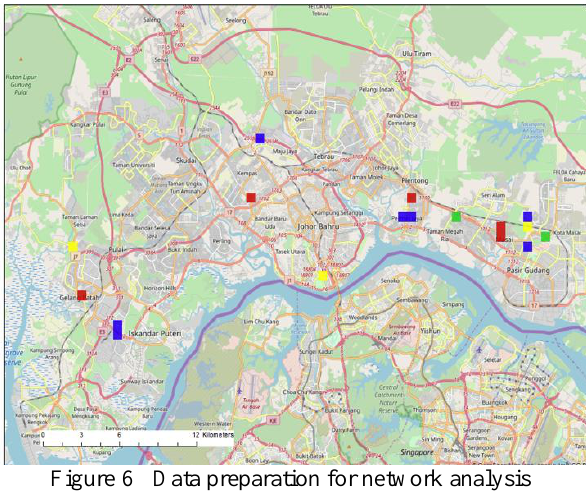
Figure 6 Data preparation for network